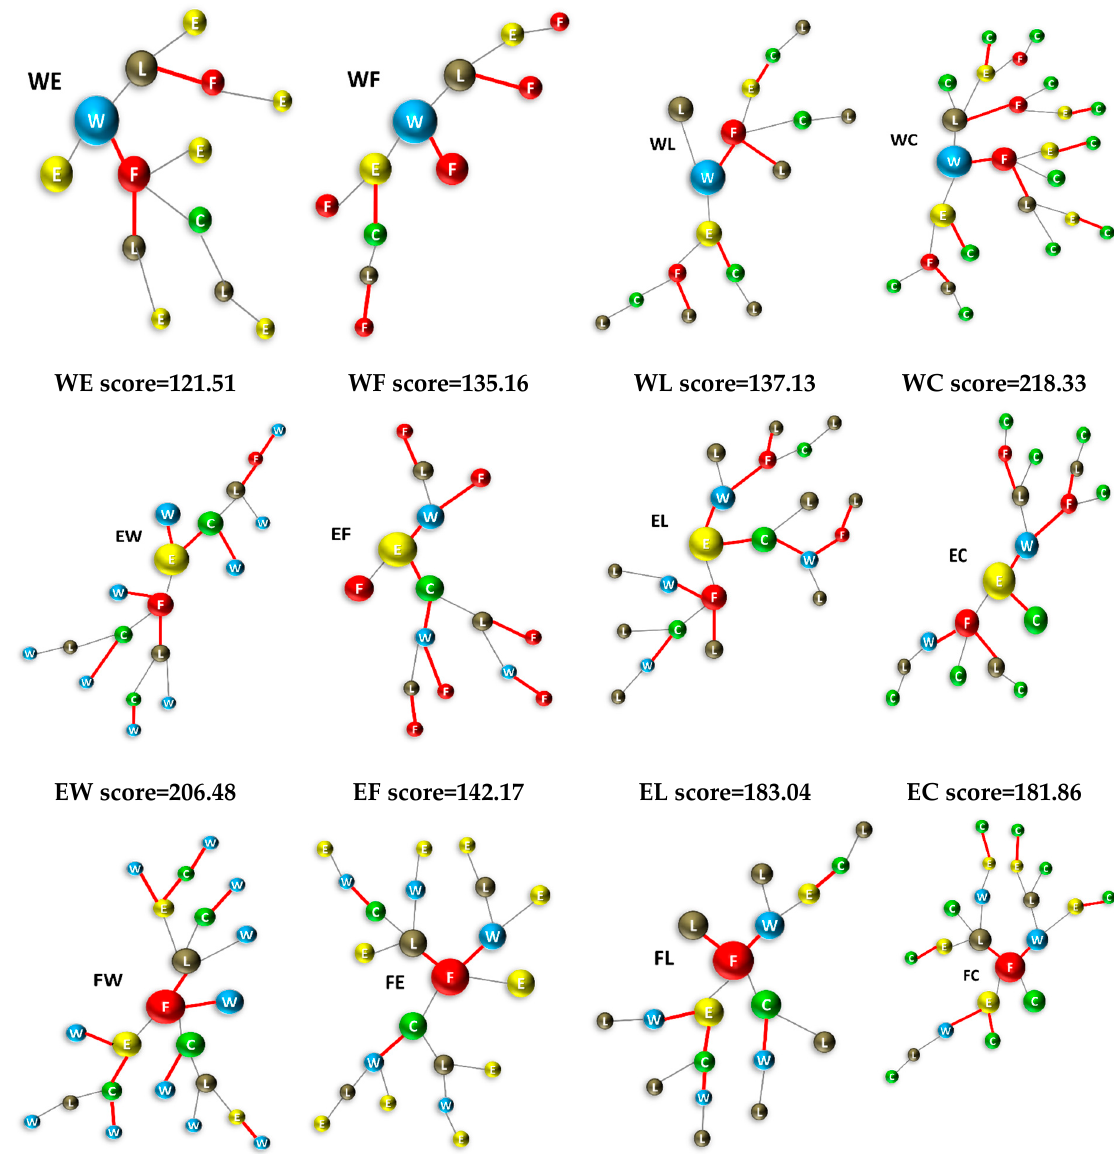
Table 1: When an interlinkage is “strong”, it is shown as a red line; when it is weak, it is shown as a black line and when it is “negligible”, the whole branch is eliminated. We see that some trees are simpler than others; e.g., CL is a simple tree with relatively few nodes and paths, while WC and FW are quite complex with multiple nodes, links and interactions. The heuristic is applied to all